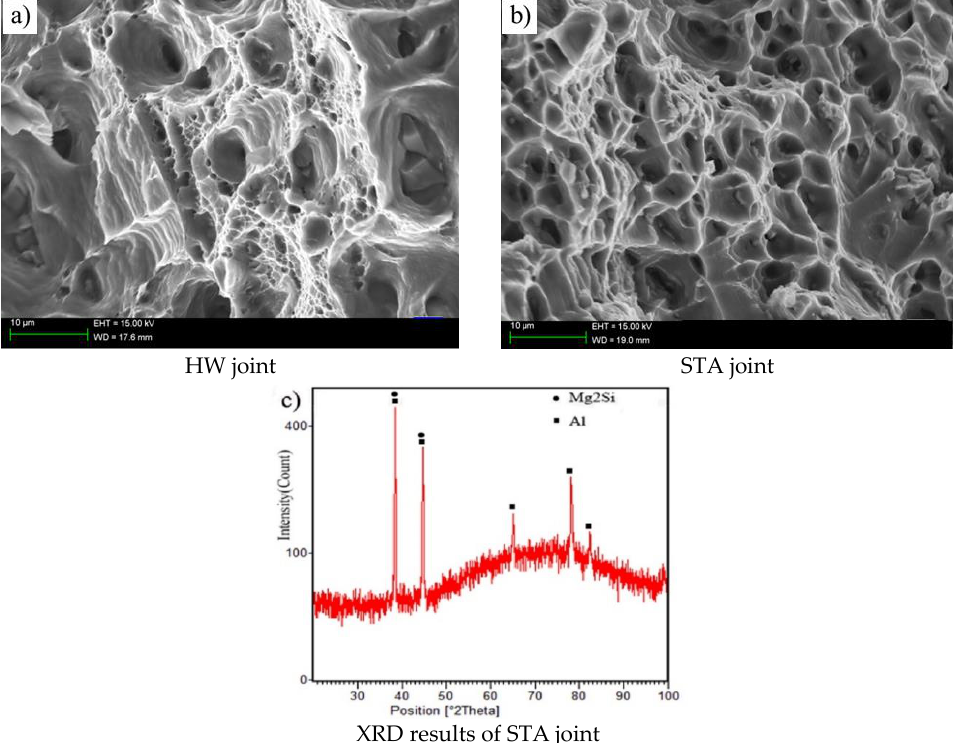
Figure 8. SEM and XRD of tensile tested specimen fractures.